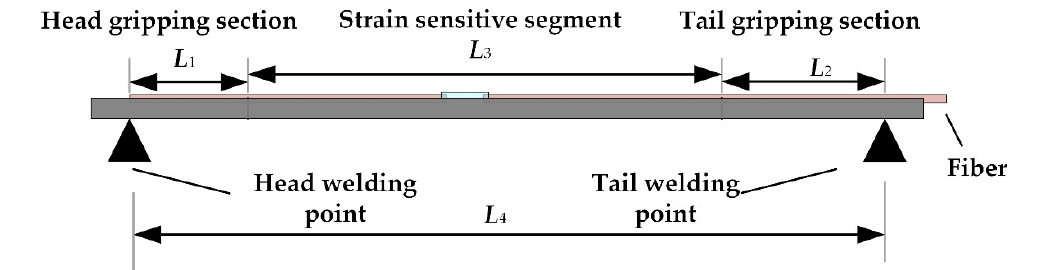
Figure 3. Schematic diagram of the sensor welding clamping model.